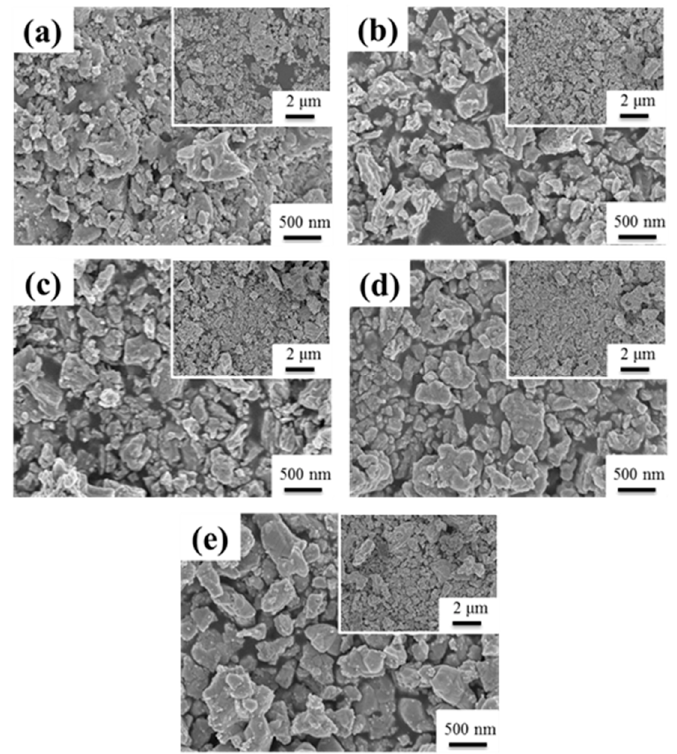
Figure 2. The SEM for SGBH100 after calcining at ( a ) 400 °C ( b ) 500 °C ( c ) 600 °C ( d ) 700 °C ( e ) 800 °C for 1 h.